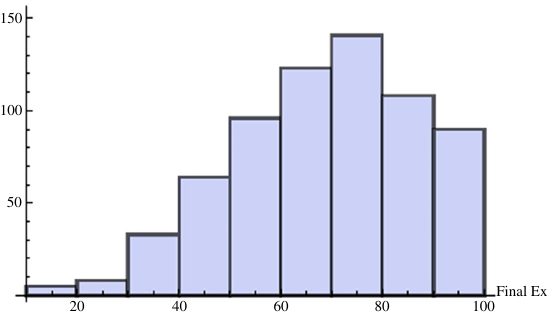
FIG. 2. Final exam scores for “ matched ”